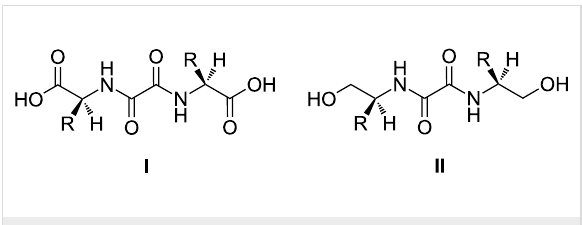
Figure 1: Chiral bis(amino acid)-( I ) and bis(amino alcohol)-( II )- oxalamide gelators.